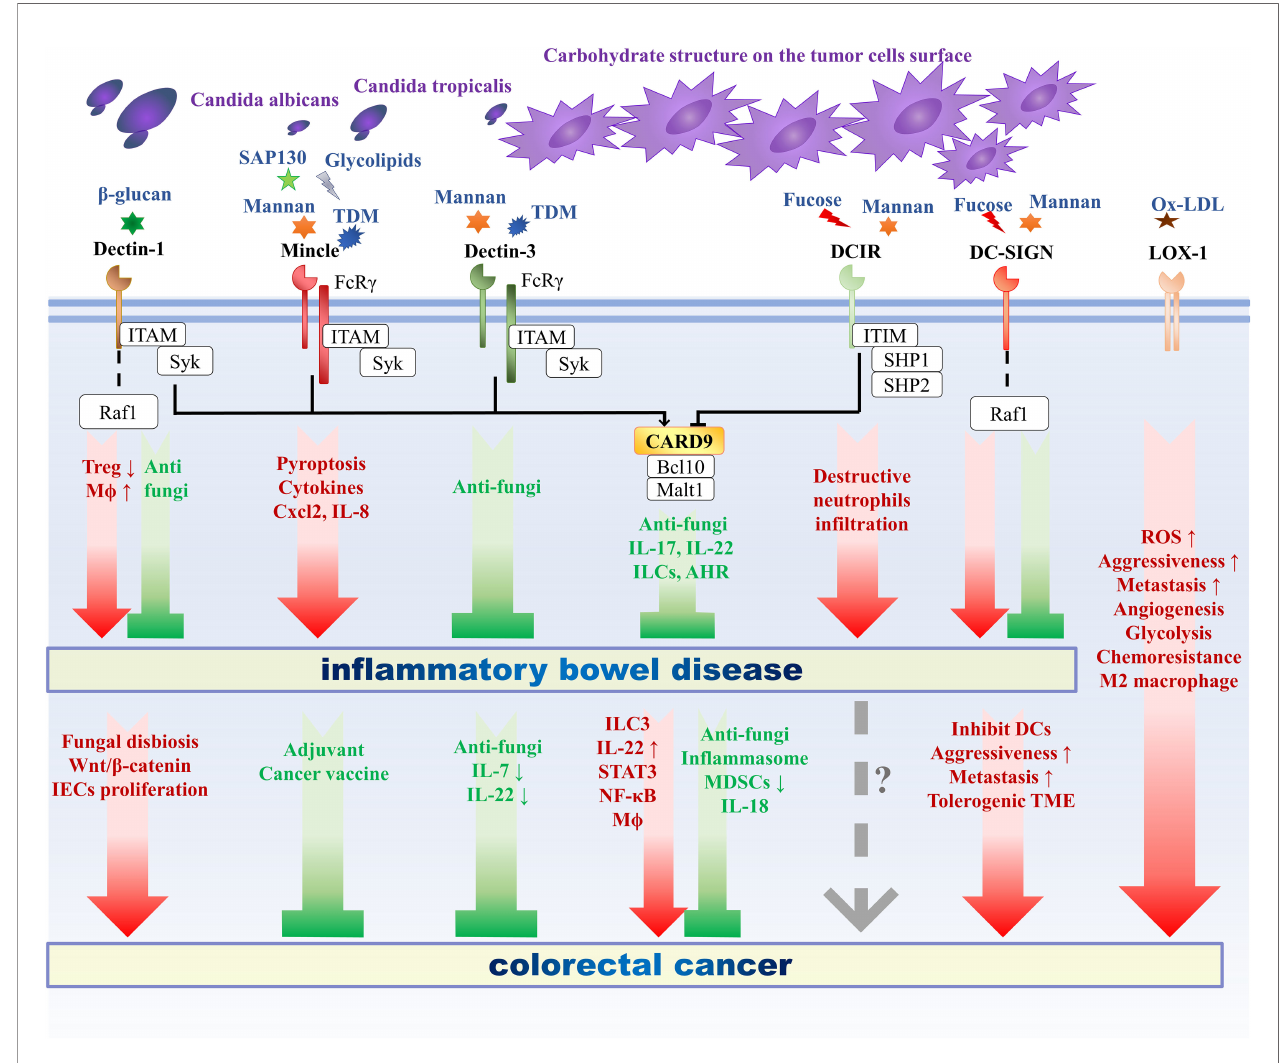
FIGURE 1 | The role of C-type lectin receptors in intestinal in fl ammation and oncogenesis. CLRs include different categories, among which Mincle and Dectin-3 belong to ITAM-coupled CLRs, Dectin-1 belongs to hemITAM-bearing CLRs, DCIR belongs to ITIM-containing CLRs, and DC-SIGN and LOX-1 belong to ITAM-ITIM independent CLRs. CARD9 functions as a crucial adaptor molecule downstream of various CLRs. Upon ligation with ligands derived from fungi or cancer, different CLRs initiate different signal transduction pathway and following immune responses, thus exerts different roles in the pathogenesis of in fl ammatory bowel disease and colorectal cancer. Mincle and DCIR exacerbate IBD, Dectin-3 and CARD9 prevent IBD, while Dectin-1 and DC-SIGN can both exacerbate and ameliorate IBD. As for CRC, Mincle and Dectin-3 play a protective role against tumor progression, Dectin-1, DC-SIGN and LOX-1 deteriorate CRC, CARD9 plays a dual role, and the role of DCIR in CRC remains unclear. CLRs, C-type lectin receptors; ITAM, immunoreceptor tyrosine-based activating motif; hemITAM, hemi-ITAM; ITIM, immunoreceptor tyrosine-based inhibitory motif; TME, tumor microenvironment; AHR, aryl hydrocarbon receptor; M f , macrophage; ROS, reactive oxygen species; DC, dendritic cell; MDSC, myeloid-derived suppressor cell; IEC, intestinal epithelial cell; ILC, innate lymphoid cell; Treg, regulatory T